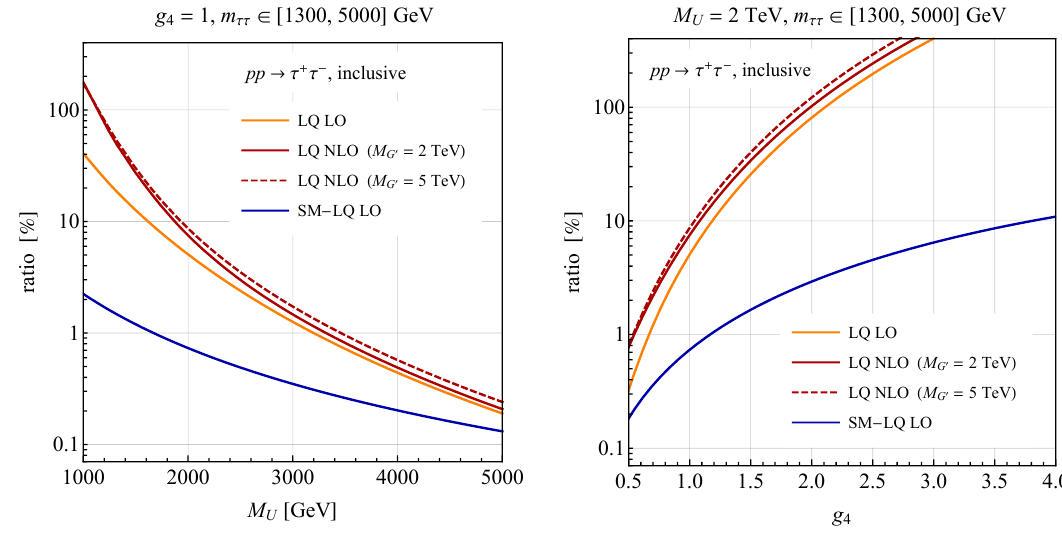
Figure 5 . Ratios between the individual LQ corrections and the inclusive DY SM background calculated at the NLO in QCD. The shown results correspond to the fiducial region defined by p T,τ > 30 GeV , | η τ | < 2 . 5 and m ττ ∈ [1300 , 5000] GeV . The left (right) plot depicts the results as a function of M U ( g 4 ) for fixed g 4 = 1 ( M U = 2 TeV ). The colour coding and meaning of the